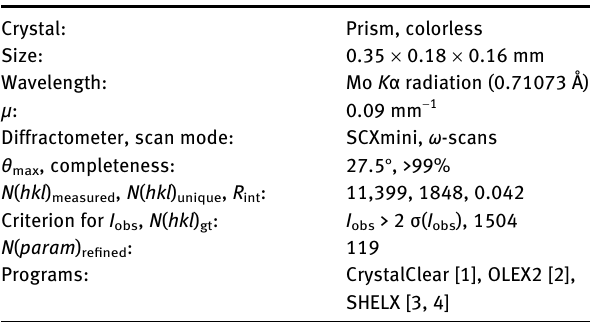
Table  : Data collection and